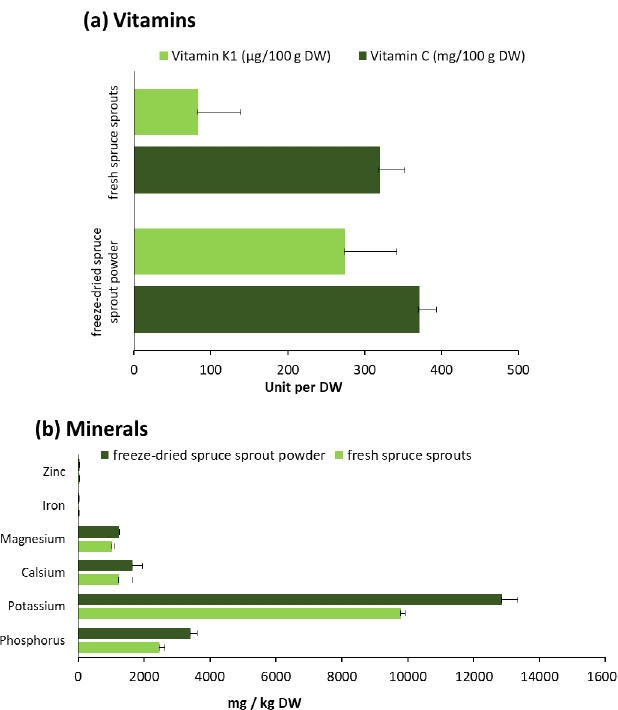
Figure 5. The average vitamin ( a ) and mineral ( b ) compositions of the fresh spruce sprouts and the freeze-dried spruce sprout powder in 2018–2019 (mg / kg DW). The results of the batch from 2017 are presented in Section 2.2.